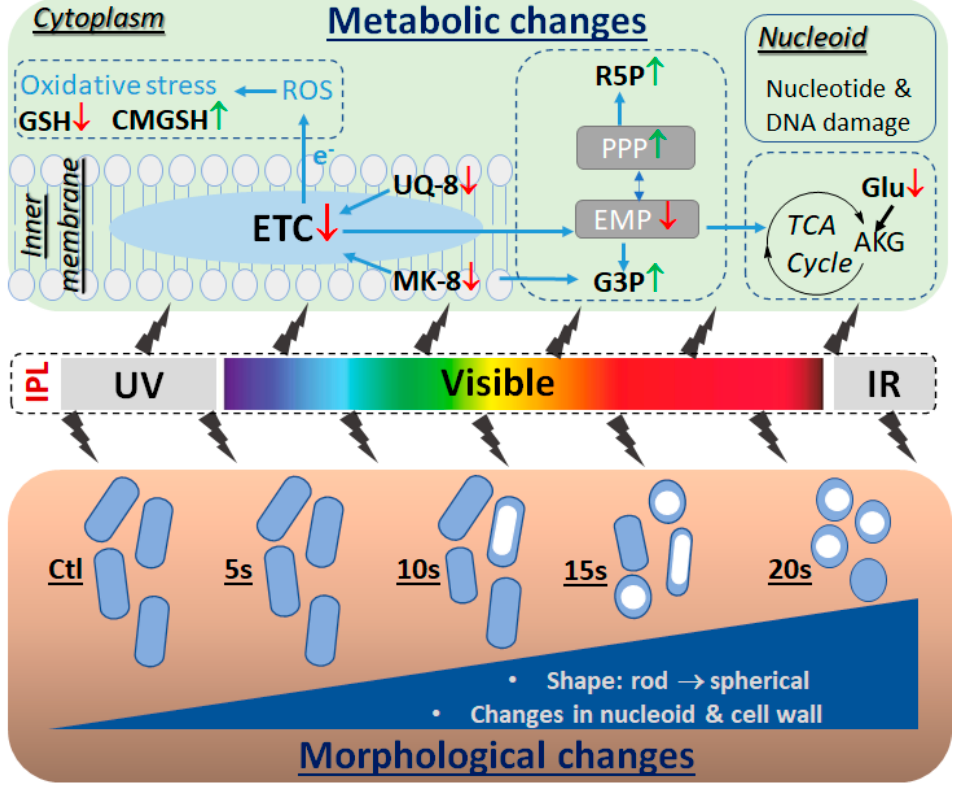
Figure 5. Summary of IPL-elicited morphological and metabolic changes in E. coli . IPL covers ultraviolet (UV), visible, and infrared (IR) light. IPL-treated E. coli cells underwent changes in size, shape, and structures, especially in the nucleoid. Metabolic changes occurred in the inner plasma membrane, cytoplasm, and nucleoid of E. coli after the IPL treatments, affecting the metabolites in ETC, oxidative stress, Embden–Meyerhof–Parnas glycolytic pathway (EMP), pentose phosphate pathway (PPP), amino acid, and nucleotide metabolism. Among them, the degradation of quinone electron carriers, especially the depletion of MK-8, is the earliest and most dramatic metabolic event induced by the IPL.